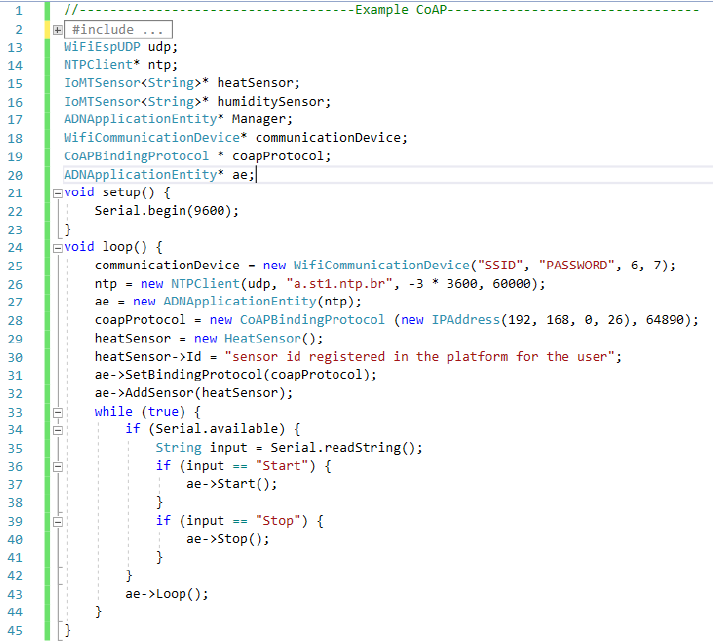
Figure 8. Example of coding of the development framework for the IoMT